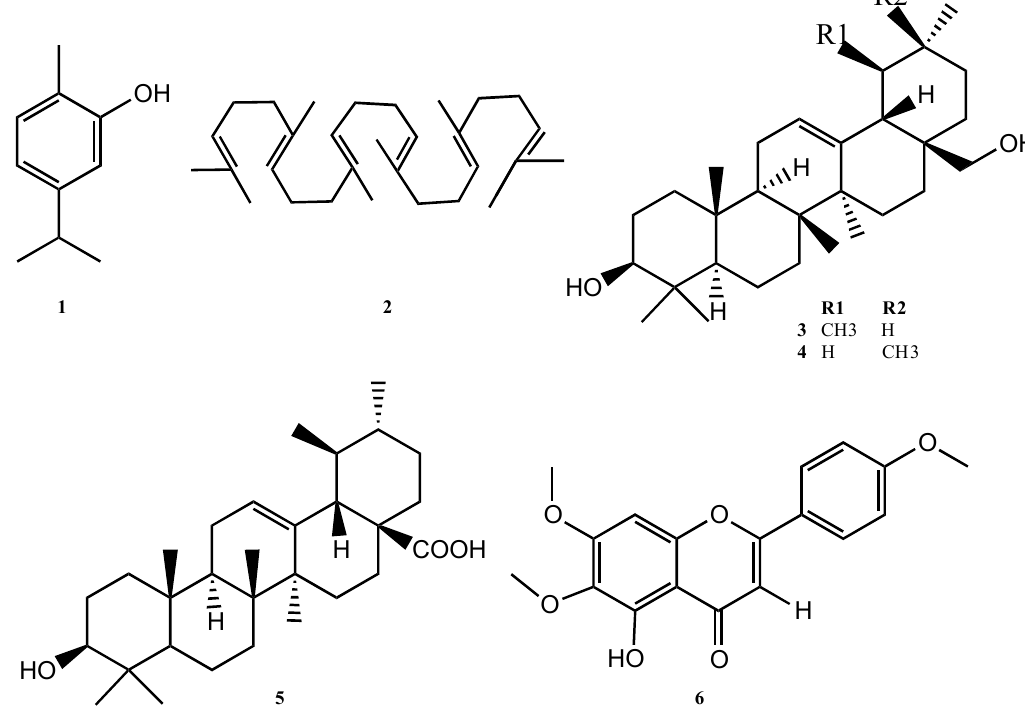
Figure 1. Structure of compounds ( 1 – 6 ) isolated from Clinopodium taxifolium .